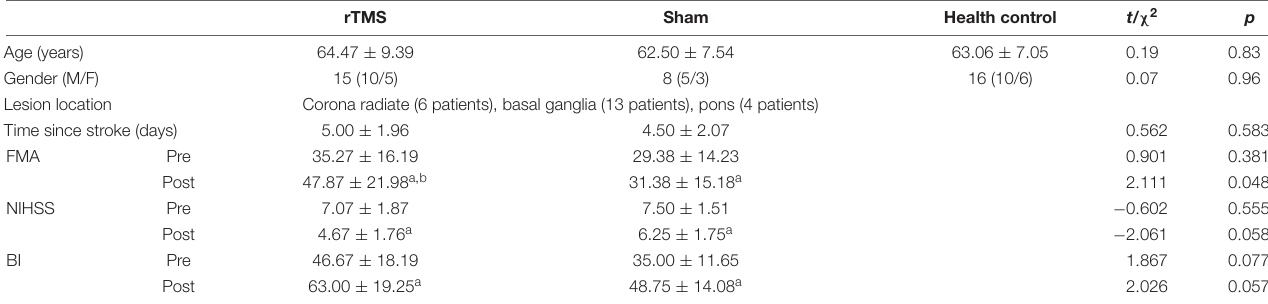
TABLE 1 | Demographical clinical characteristics of all the included